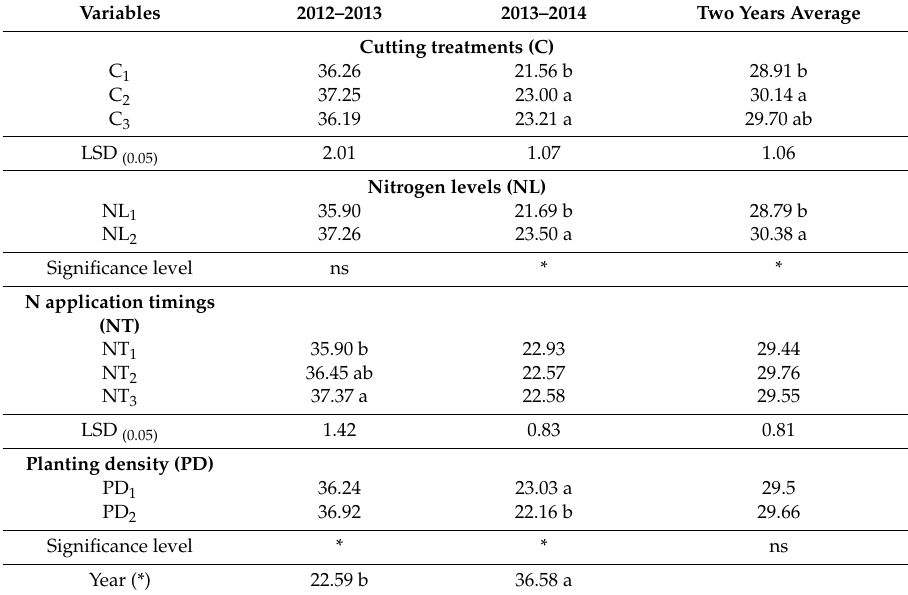
Table 6. Canola protein content (%) in response to cutting treatments, nitrogen levels and application timings under varying planting